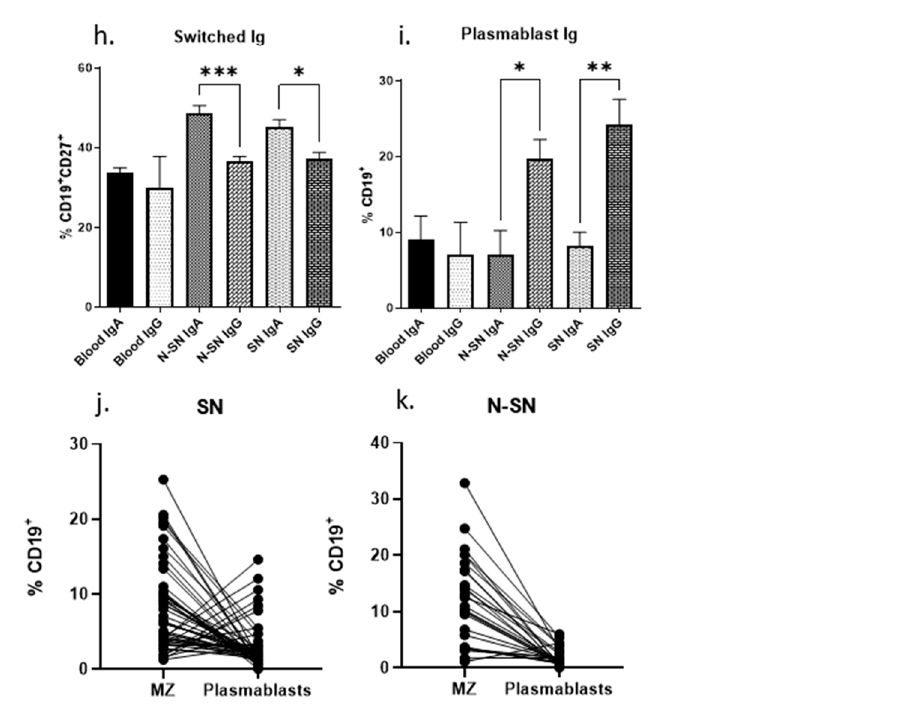
Figure 5. B-cell distribution in SN and N-SN. ( a ) Correlation of clinical parameters and CD19 B cells in lymph nodes of patients. Patients were stratified based on clinical parameters and analyzed for B-cell populations. ( b , c ) B cells stained for different isotypes. Mean percentages of CD19 + B cells in total lymphocytes and of the B-cell subpopulations in CD19 + lymphocytes are shown. All error bars indicate SEM. Percentages of lymphocyte subpopulations were compared with the Student two-tailed t -test. p : * ≤ 0.05, ** ≤ 0.01 *** ≤ 0.001 **** ≤ 0.0001.